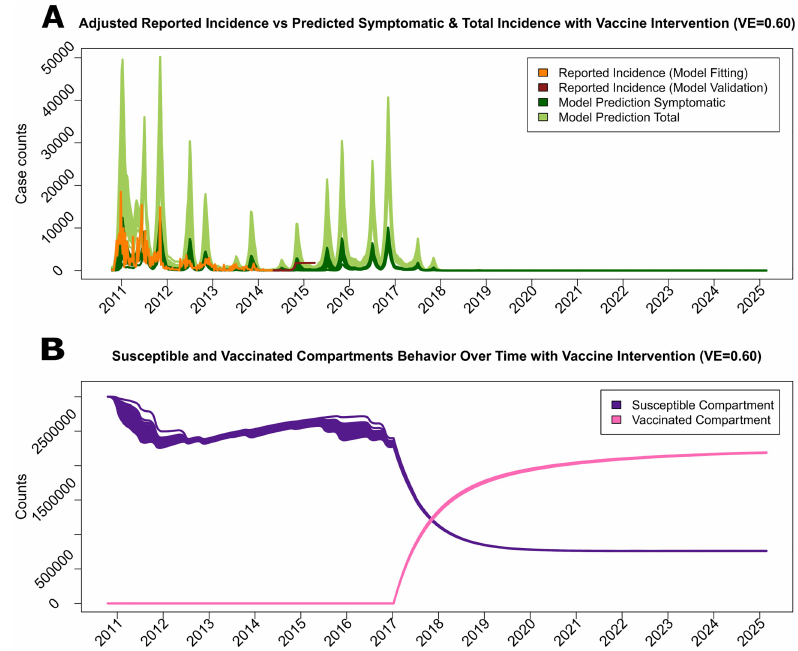
Fig 4. The cholera incidence simulated by the model is presented for the next 10 yearswith vaccine intervention, along with the number of susceptible and vaccinatedpopulation members. The intervention was initiatedJanuary1, 2017, assuminga 60% vaccine efficacy, 3 year durationof immunity, and an averagewaiting time to be vaccinatedof 50 weeks. The upper panel(A) presents the observedincidence of symptomatic cholera cases (orangeand dark red), the model-fitted incidenceof symptomatic cases (dark green), and both symptomatic and asymptomatic cases (light green). The lower panel (B) displaysthe numbers of susceptible (purple)and vaccinated(pink)